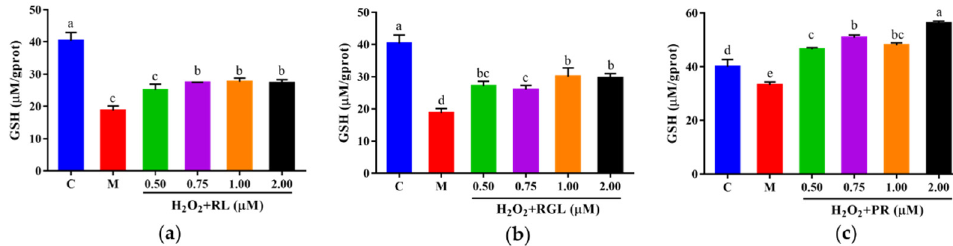
Figure 13. GSH level of HepG2 cells with oxidative stress treated with synthetic peptides: ( a ) synthetic peptide RL; ( b ) synthetic peptide RGL; ( c ) synthetic peptide PR. “C” represents the control group, and “M” represents the model group. Data were expressed as mean ± SD ( n ≥ 3, p < 0.05). Different letters indicate significant differences ( p < 0.05).